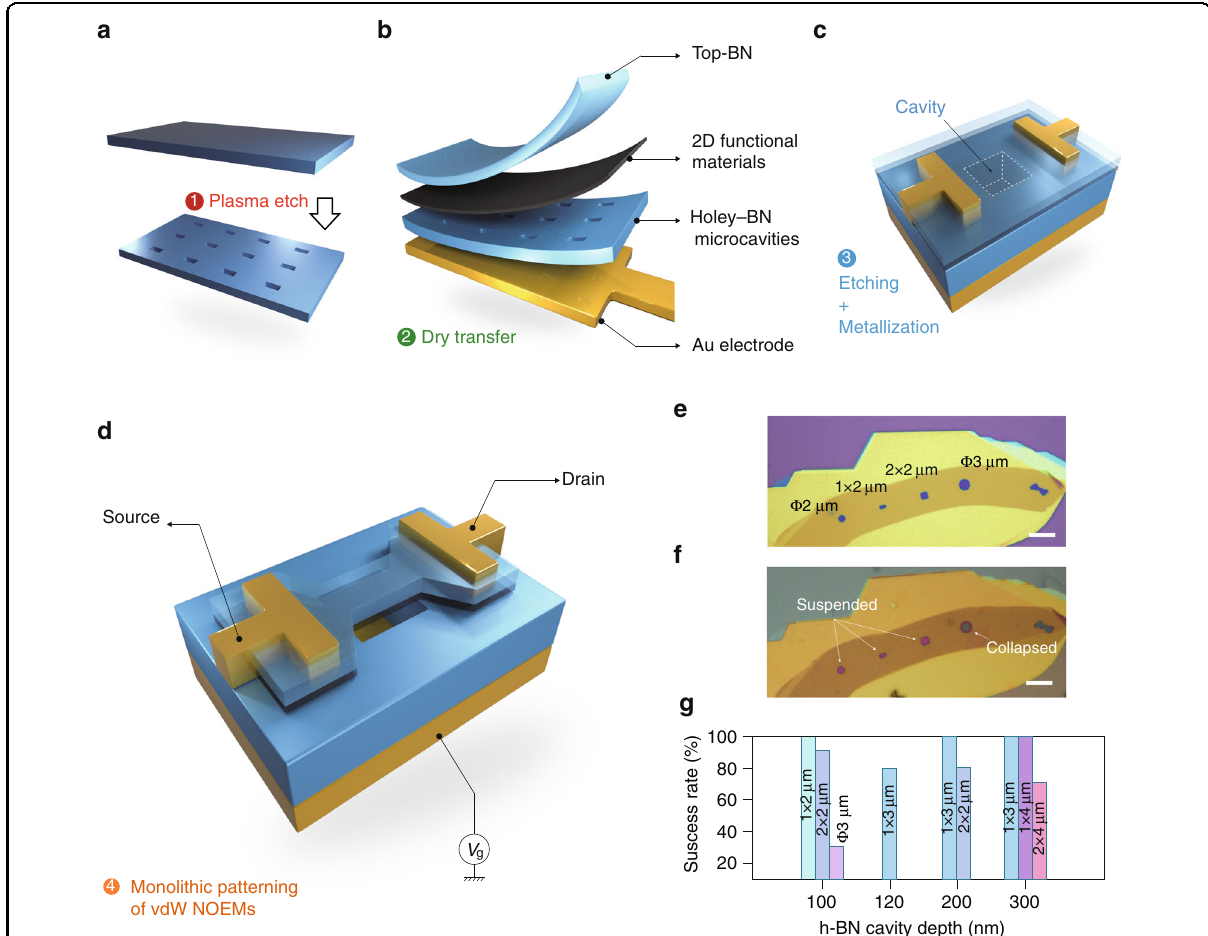
Fig. 1 Monolithically sculpted vdW heterostructure NOEMS. a – d Art view of the work fl ow for patterning suspended vdW heterostructure beams on h-BN cavities, with 2D functional materials involved, thus forming a NOEMS structure. e – f A typical test on the suspension of vdW heterostructure on pre-patterned h-BN holes, with a global top vdW layer ( f ) deposited onto ( e ). g A statistic on the success rate of suspension (at step 3 in Fig. 1) of h-BN/graphene heterostructure on h-BN cavities with different h-BN cavity depths. The different colors denote lateral sizes of the suspended areas. Ten samples were fabricated for each size for the statistic in ( g